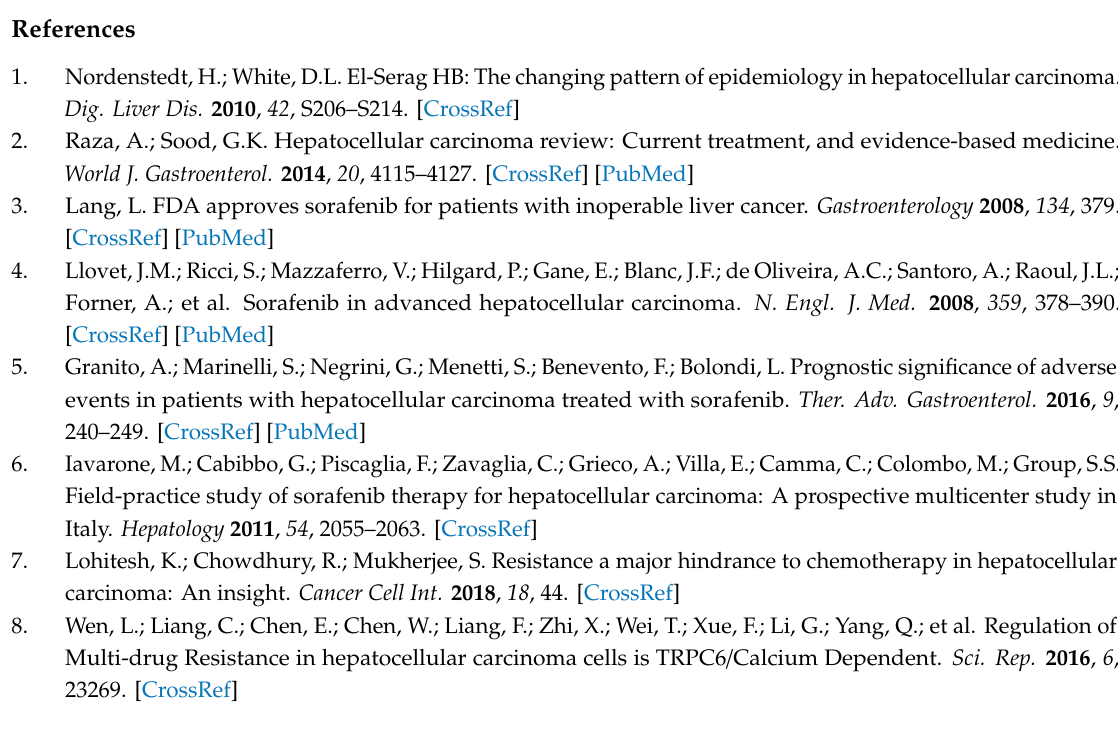
Figure S1: Representative dot plots for CCR7 / CD45RA and CD69 / PD-1 staining in T cells, Figure S2: Lymphocyte gating